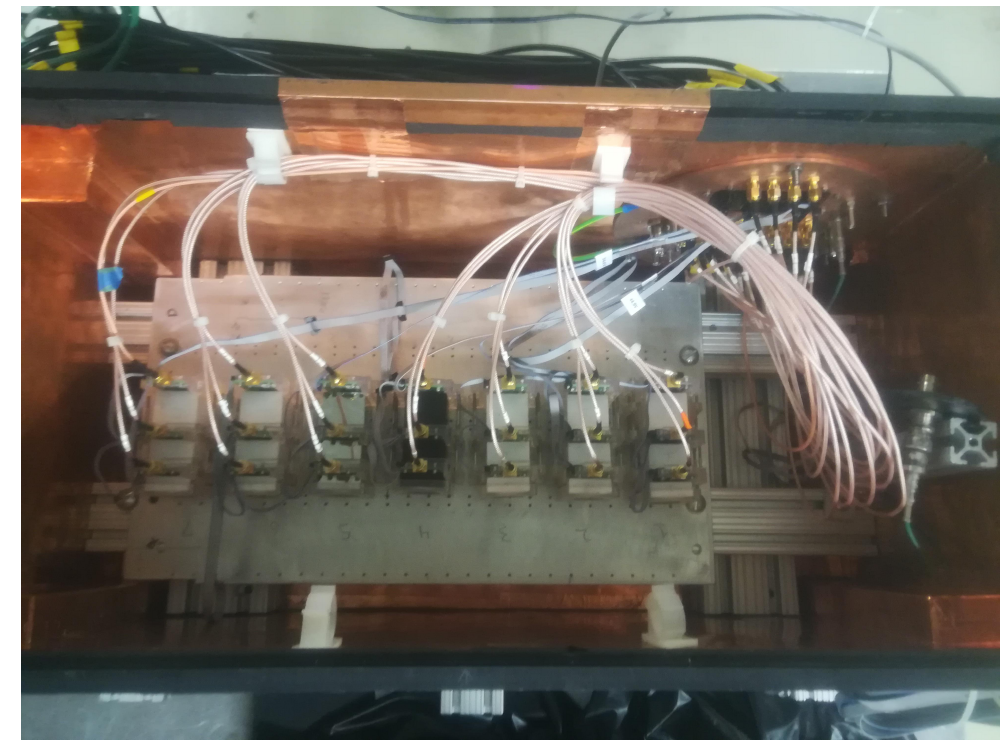
Figure 5. Setup of a test beam at Fermilab’s FTBF of seven triplets of ADRIANO 2 tiles. The average light yield (photoelectron/mip), measured at the center of the tile for twenty-one triplets is summarized in Figure 6. The x-axis indicates the thickness of the